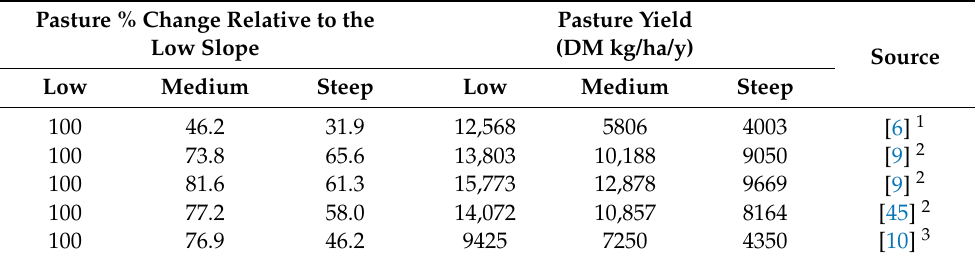
Table 3. Published percentage of pasture production on medium and steep slopes relative to the low slope and the estimated pasture yields from the three slope classes (low, medium, and steep) on New Zealand North Island sheep and beef hill country farms. Pasture % Change Relative to the Pasture Yield Low Slope (DM kg/ha/y) Source Low Medium Steep